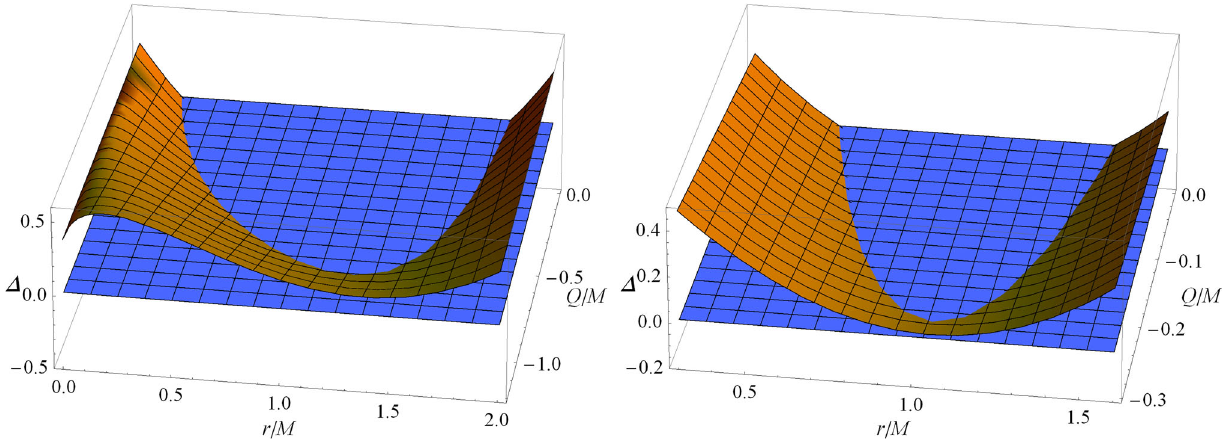
Fig. 2 Plot showing the variation of (cid:14) with r for different values of parameters Q for a = 0 . 6 M (left) and a = 0 . 9 M (right). The blue surface correspond to (cid:14) = 0 and values at the intersection points between two surfaces are the radii of horizons